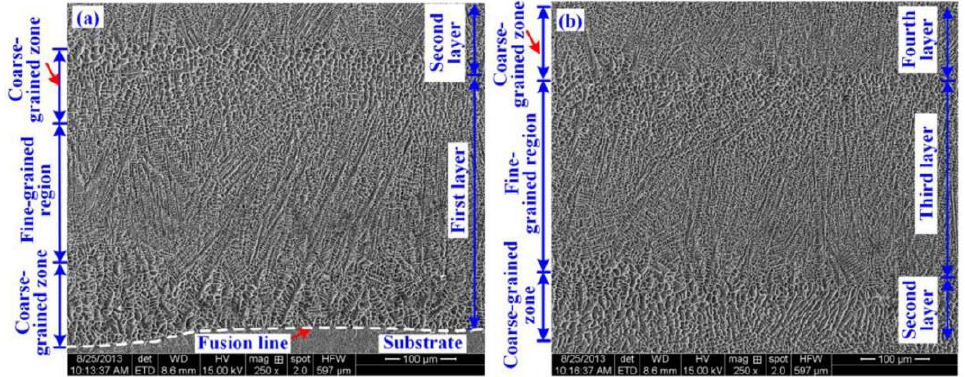
Figure 11. The grains structure of the specimen cross-section: ( a ) substrate and first layer, ( b ) second, third and fourth layer.